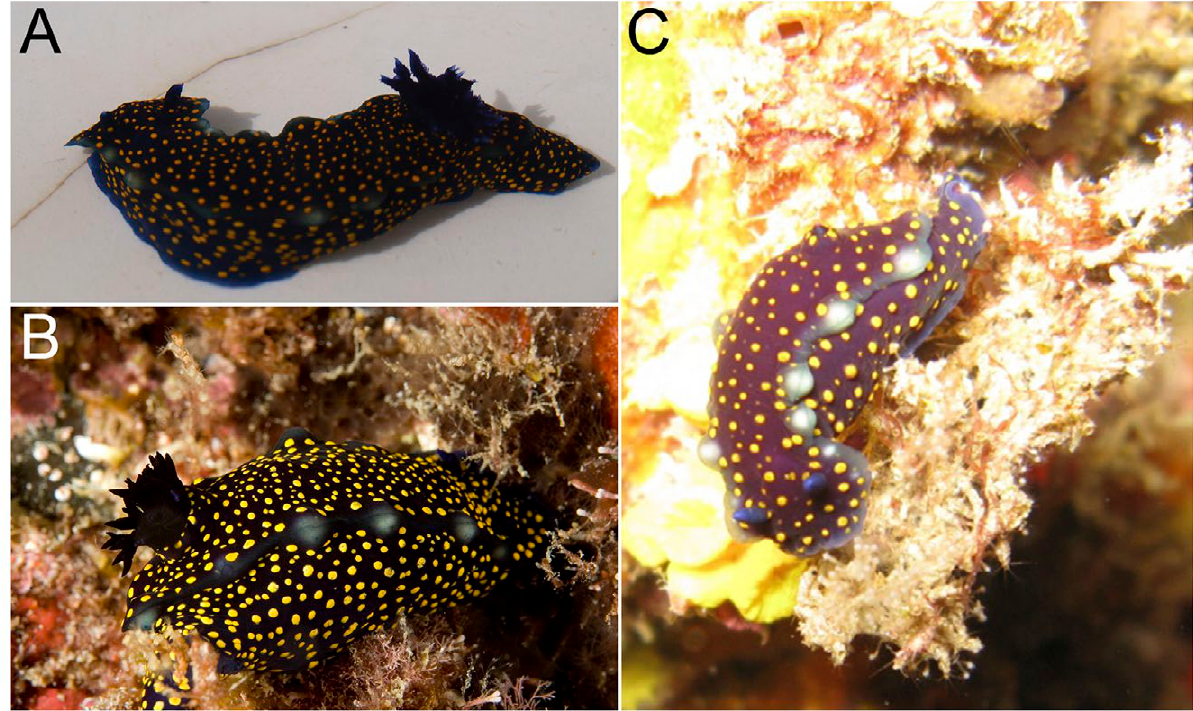
Fig. 2. – Living specimens of Felimare aurantimaculata n. sp. A, B, paratype (MB28-004391); C, holotype (MB28-004390) (photos: A, B, P. Wirtz; C, J.